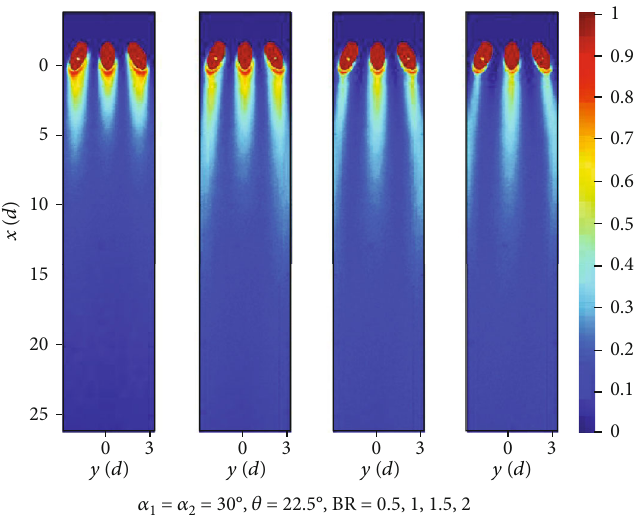
Figure 10: Film cooling e ff ectiveness distributions downstream of the branched holes, α